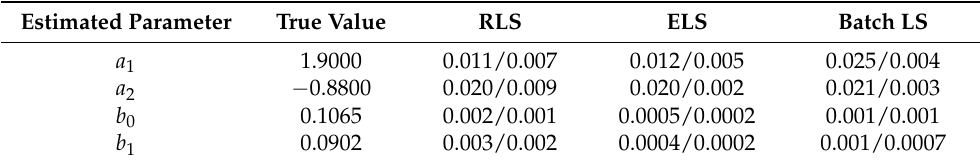
Table 1. Mean/Standard Deviation of Estimation Technique Errors.